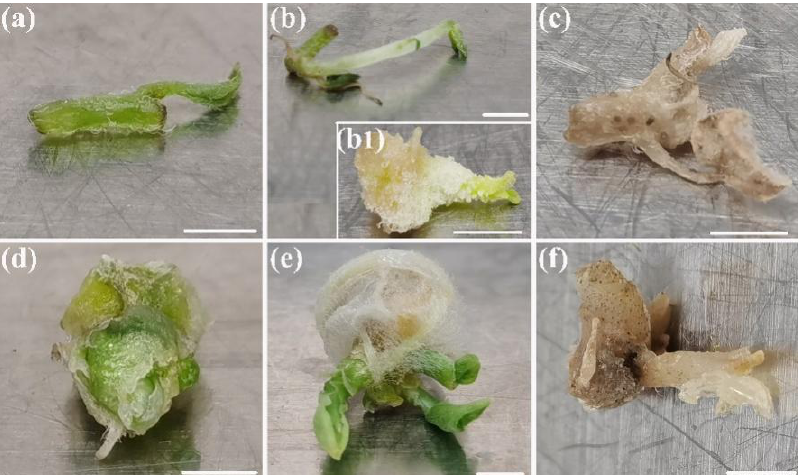
Figure 3. Survival and new tissue regeneration by micro-cuttings or loss of vitality. ( a ) Potato ZHB survived cutting without new tissue germination; ( b ) new tissue germinated ZHB cuttings, ( b1 ) ZHB micro-cutting with callus and bud germination; ( c ) dead ZHB cuttings; ( d – f ) ginger G-2 survived cutting, new tissue germinated, and dead cutting, respectively. Images were acquired post 60 d of conservation. Bar indicates 2 mm.